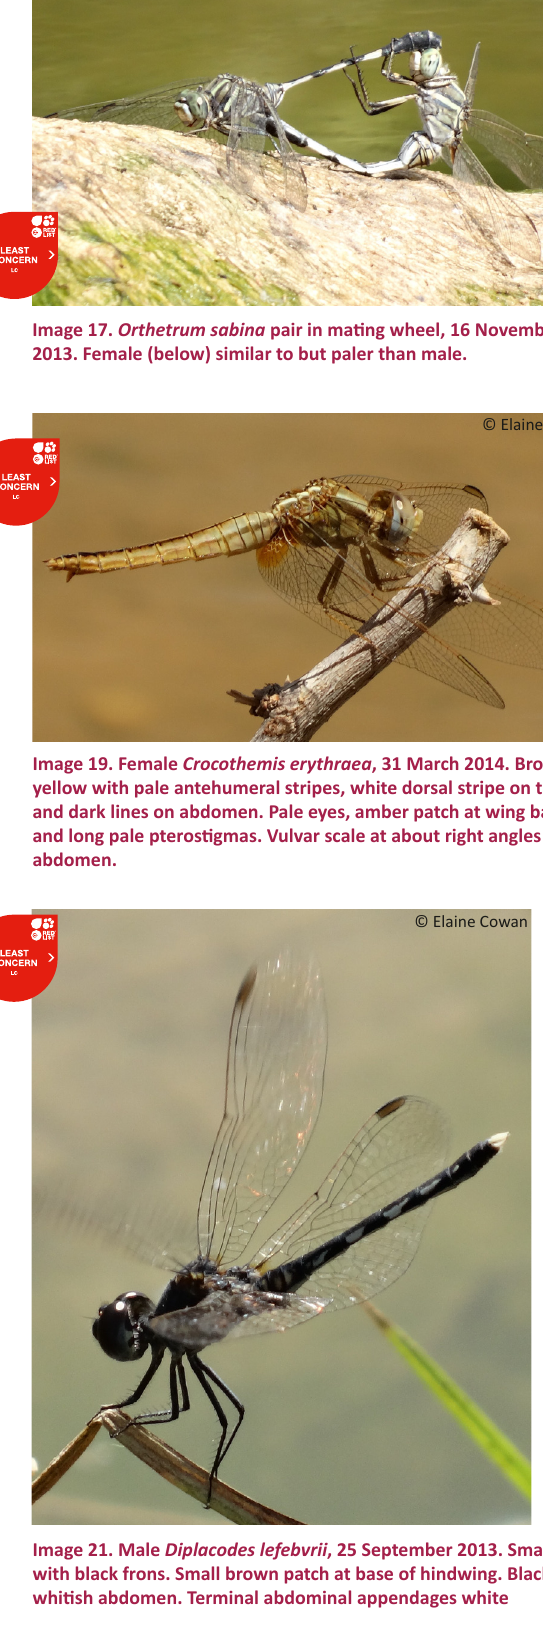
whitish abdomen. Terminal abdominal appendages